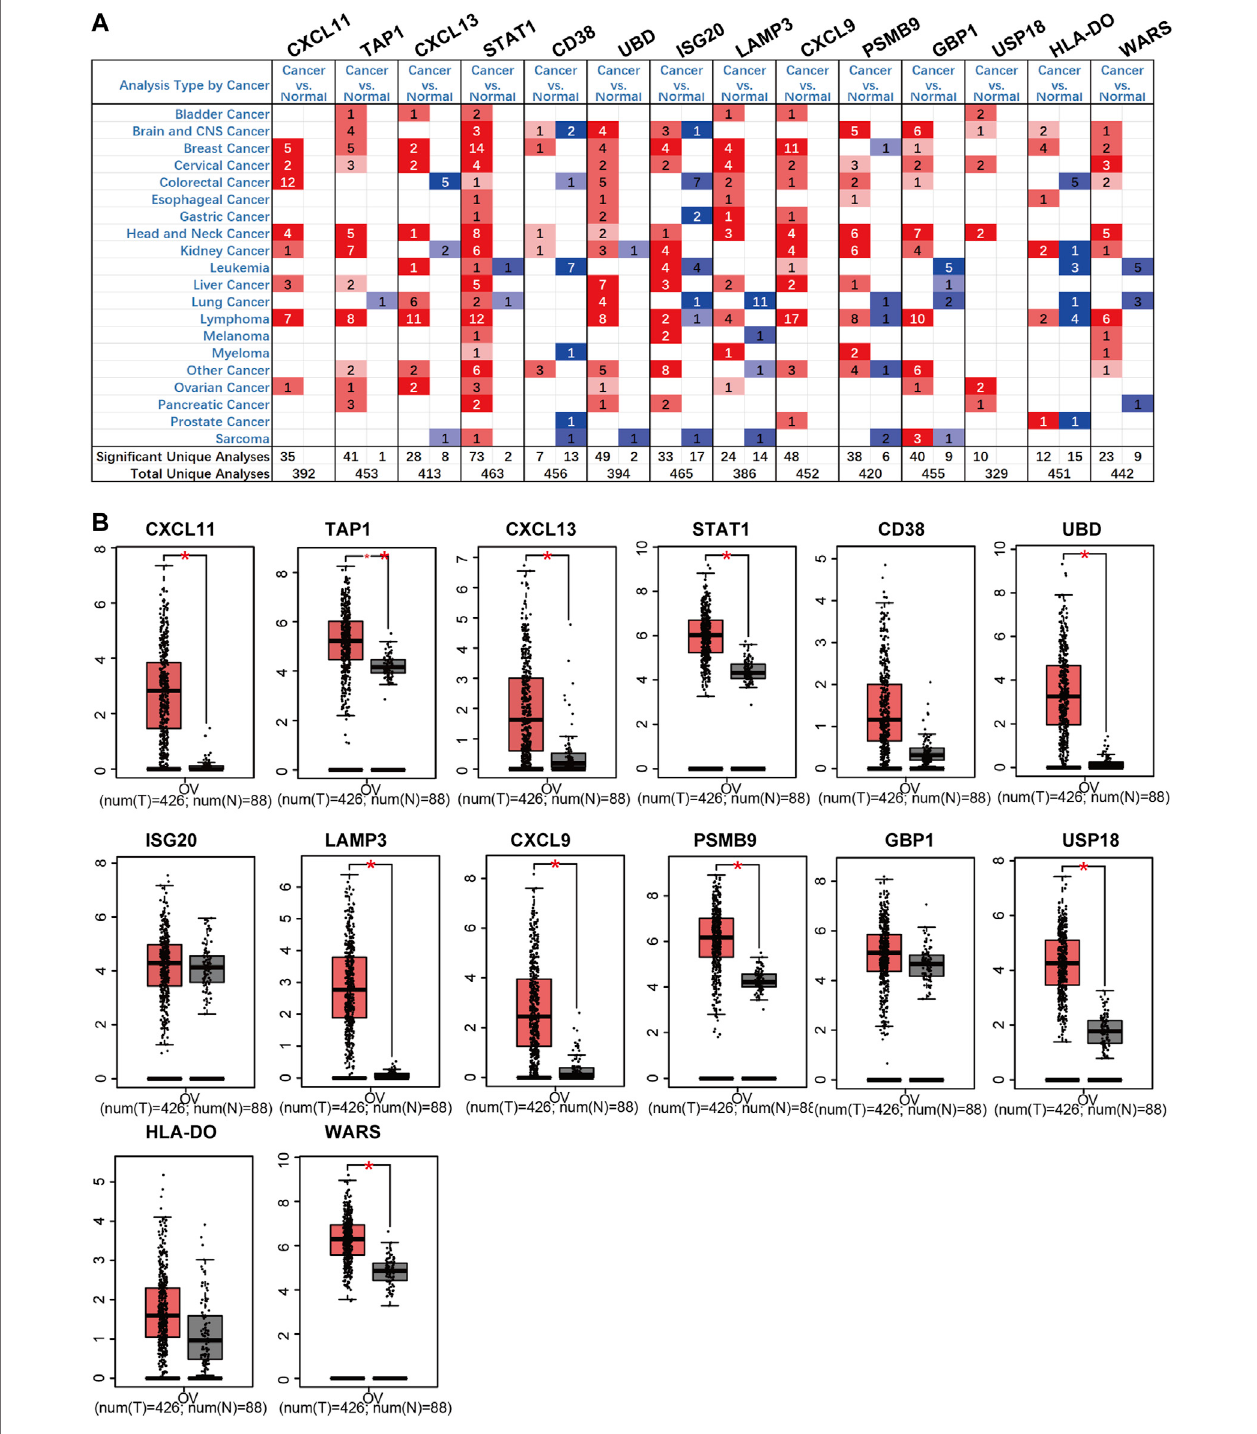
FIGURE 5 | The mRNA expression of up-regulation prognostic genes in ovarian cancer tissues and normal tissues (Oncomine and GEPIA). (A) The mRNA expression on the Oncomine. (B) The mRNA expression on the GEPIA.